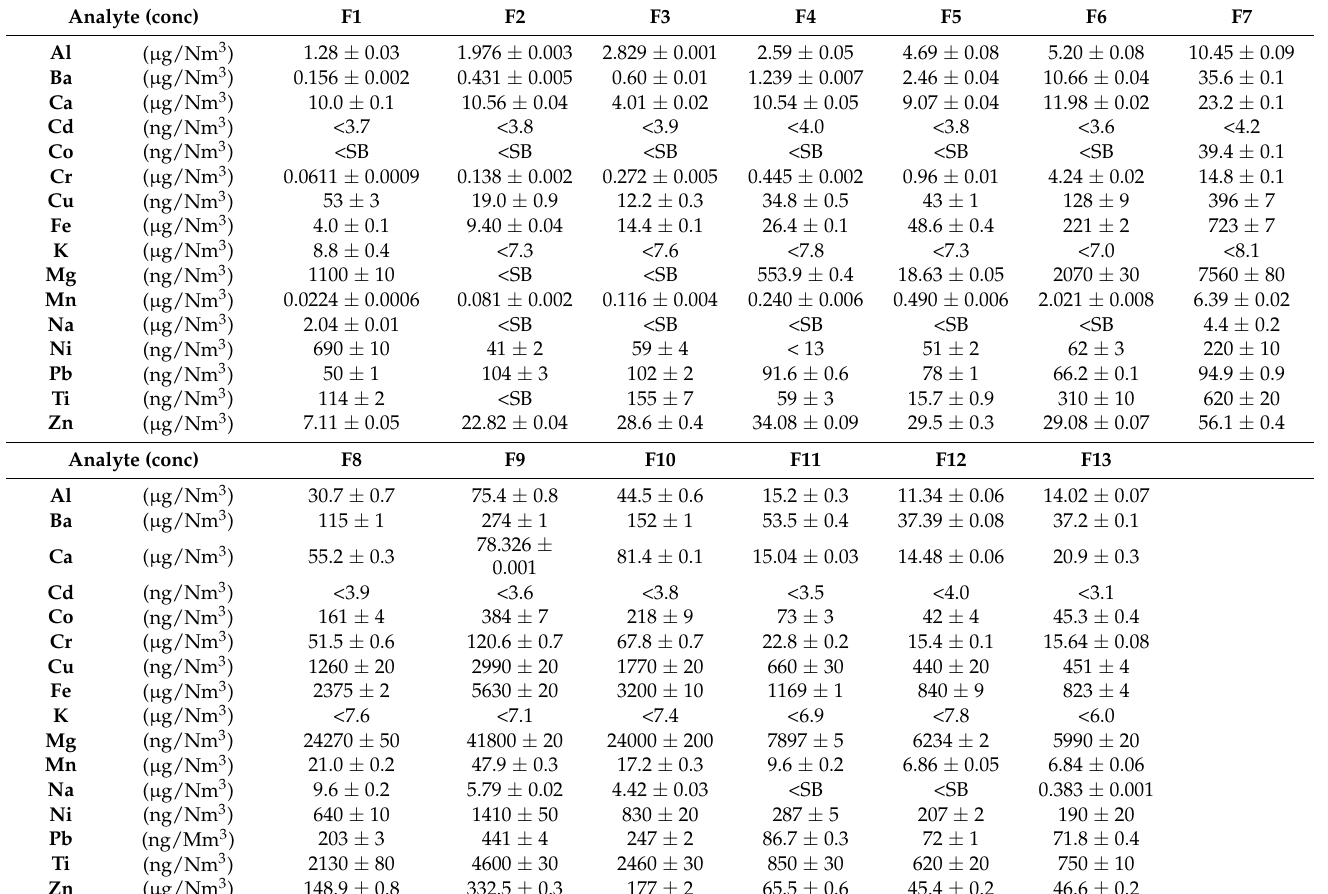
Table A5. Elemental concentrations and standard deviations found in airborne brake wear particles (oven